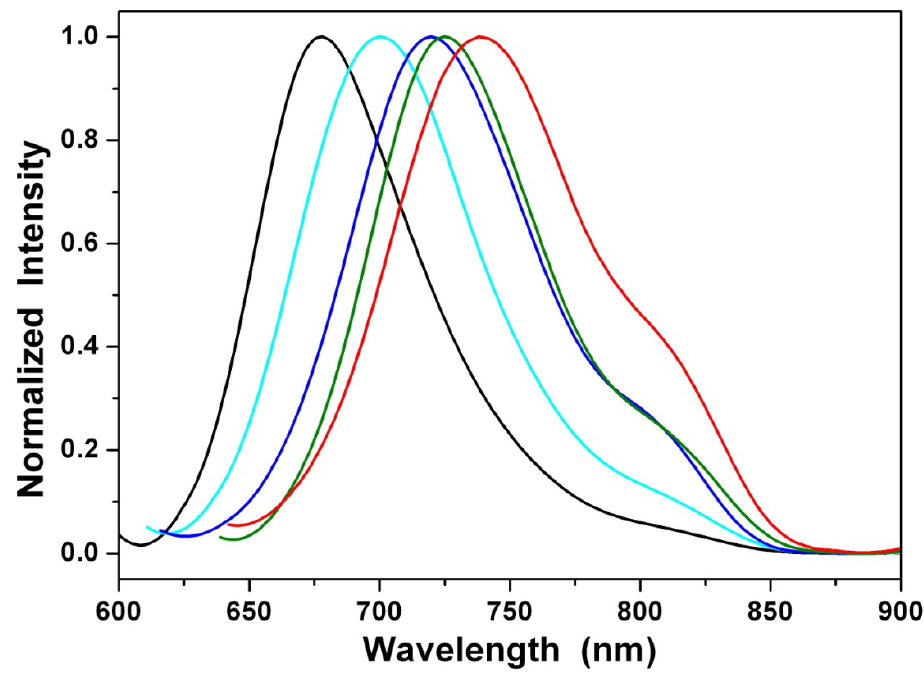
Figure 4. Normalized emission spectra of 1a in cyclohexane (black line), diethyl ether (cyan line), ethyl acetate (blue line), dichloromethane (green line) and acetonitrile (red line).